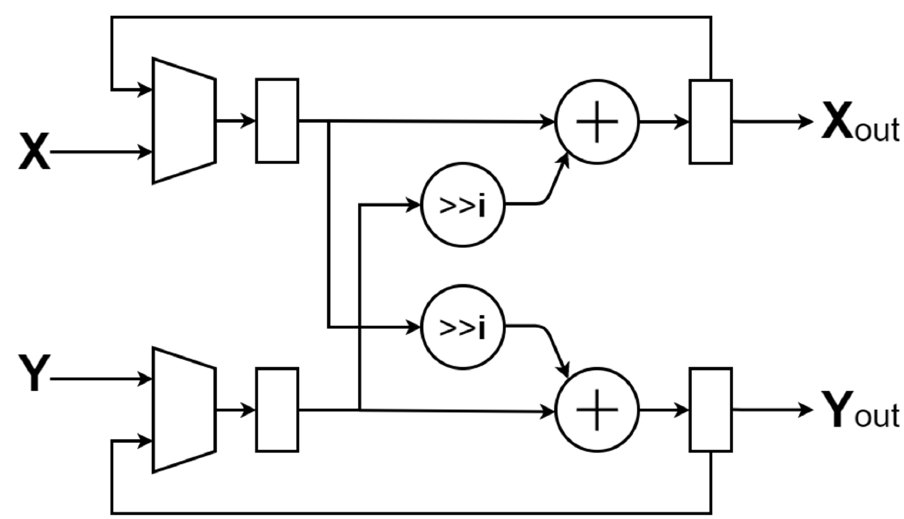
Figure 9. The architecture of the hardware-sharing machine recursive CORDIC.